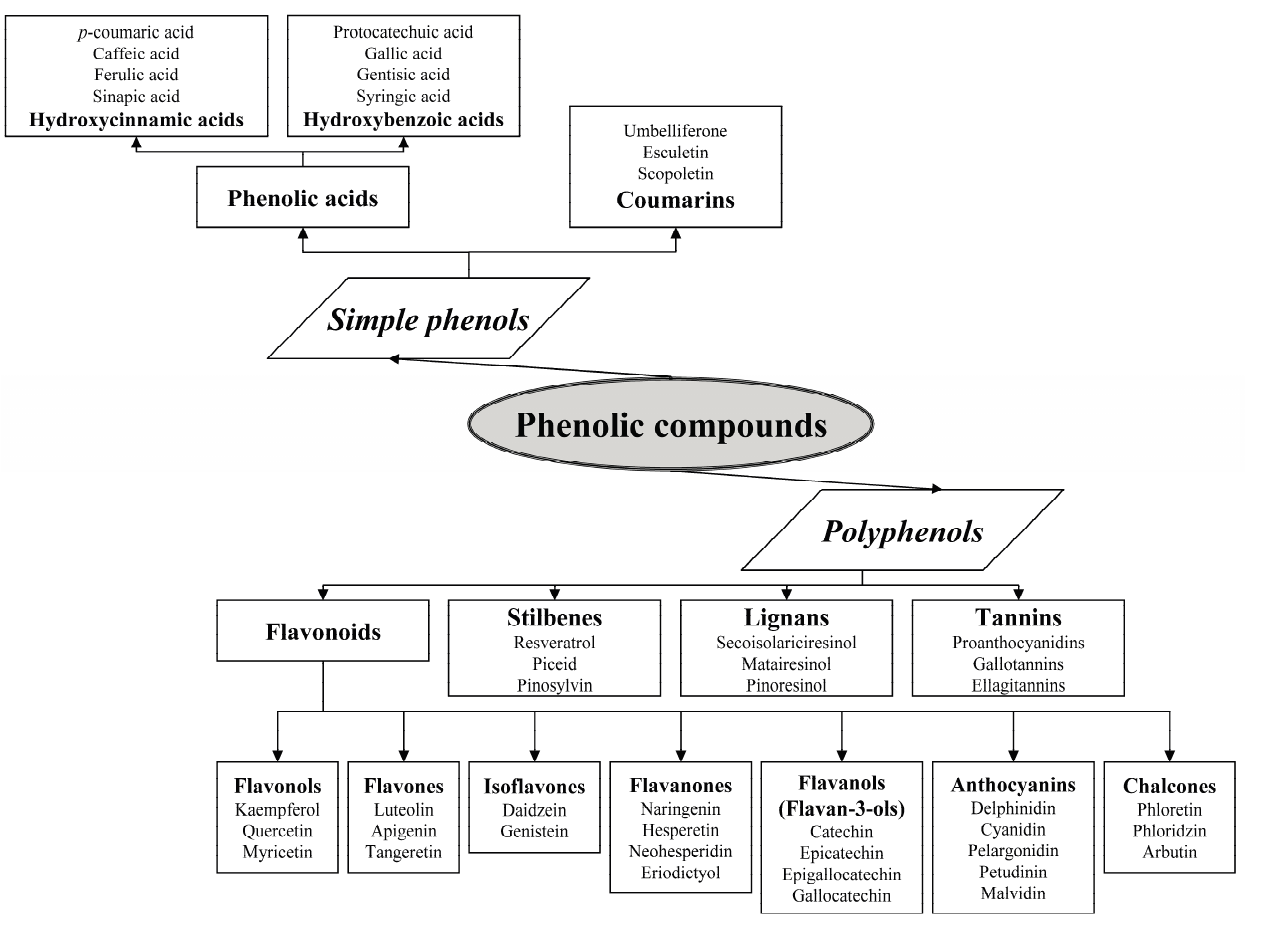
Figure 1. Classification of phenolic